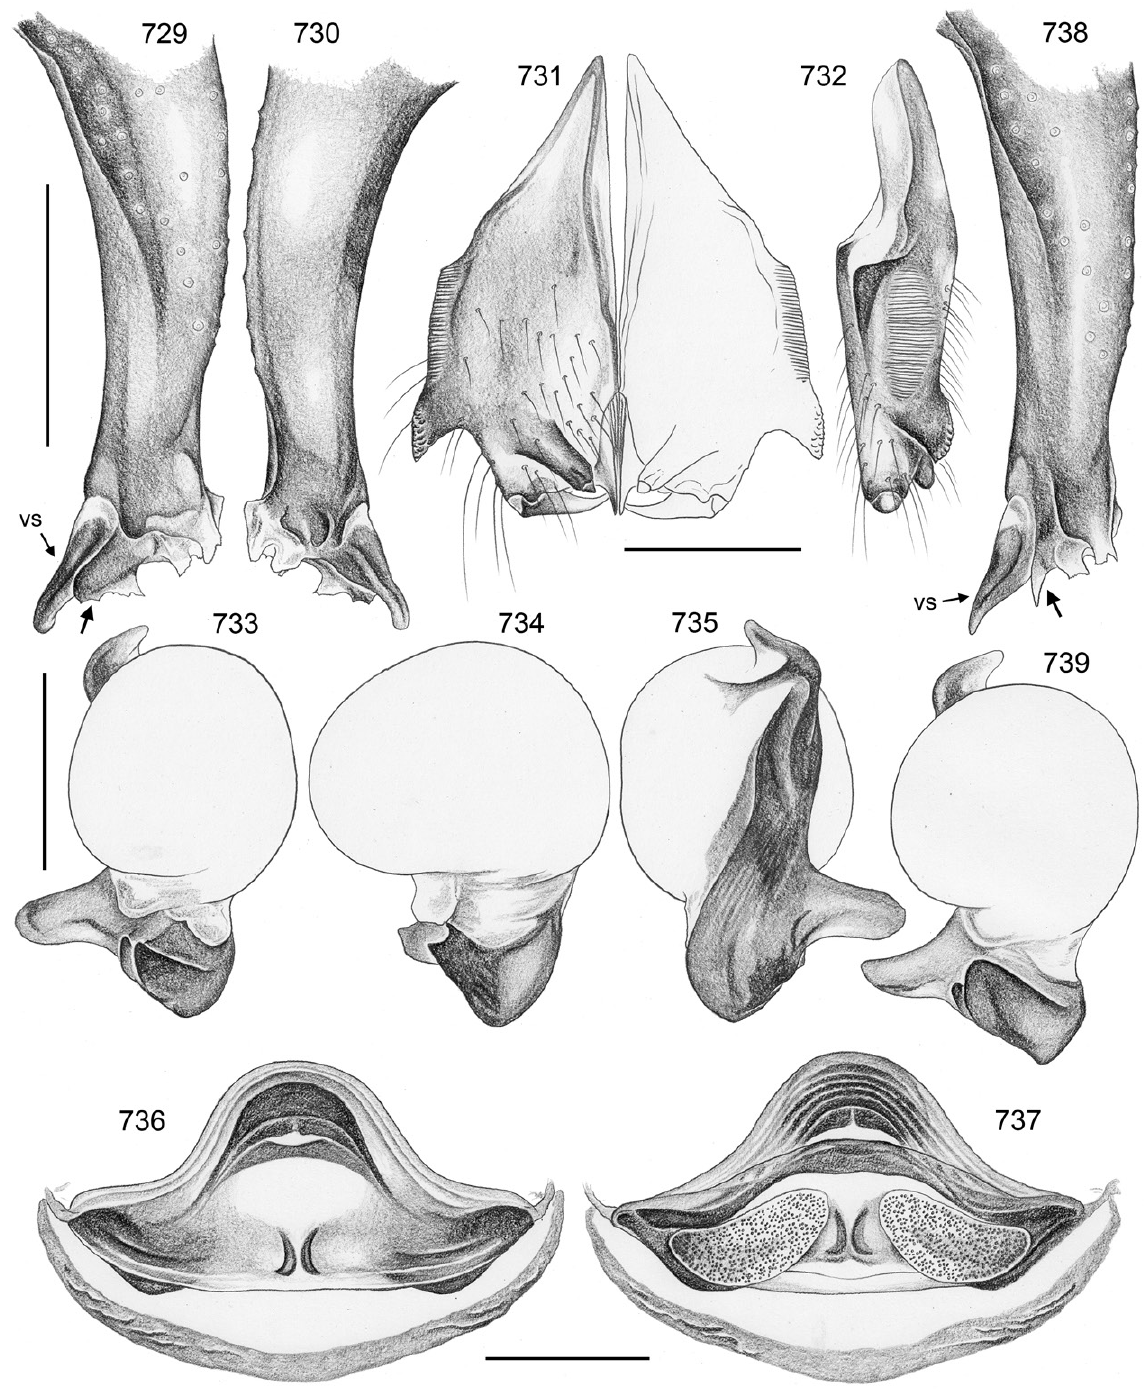
Figs 729–739. Crossopriza parsa sp. nov.; non-type male and female from Iran, Persepolis (MHNG) (729–737) and male from Iran, W of Dasht-e-Arjân (MHNG) (738–739). 729–730 . Left procursus, prolateral and retrolateral views; arrow: prolateral process. 731–732 . Male chelicerae, frontal and lateral views. 733–735 . Left genital bulb, prolateral, dorsal, and retrolateral views. 736–737 . Cleared female genitalia, ventral and dorsal views. 738 . Left procursus, prolateral view; arrow: prolateral process. 739 . Left genital bulb, prolateral view. Abbreviation: vs = ventral sclerite. Scale bars = 0.3